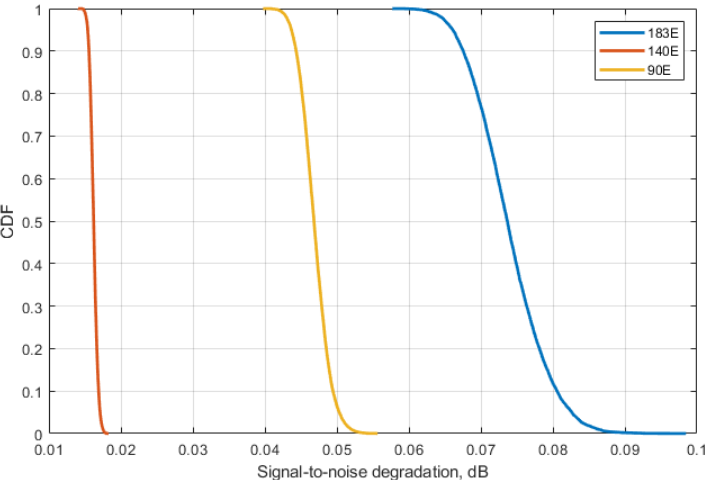
Figure 13. Cumulative distribution functions of C/N reduction for each victim satellite link.